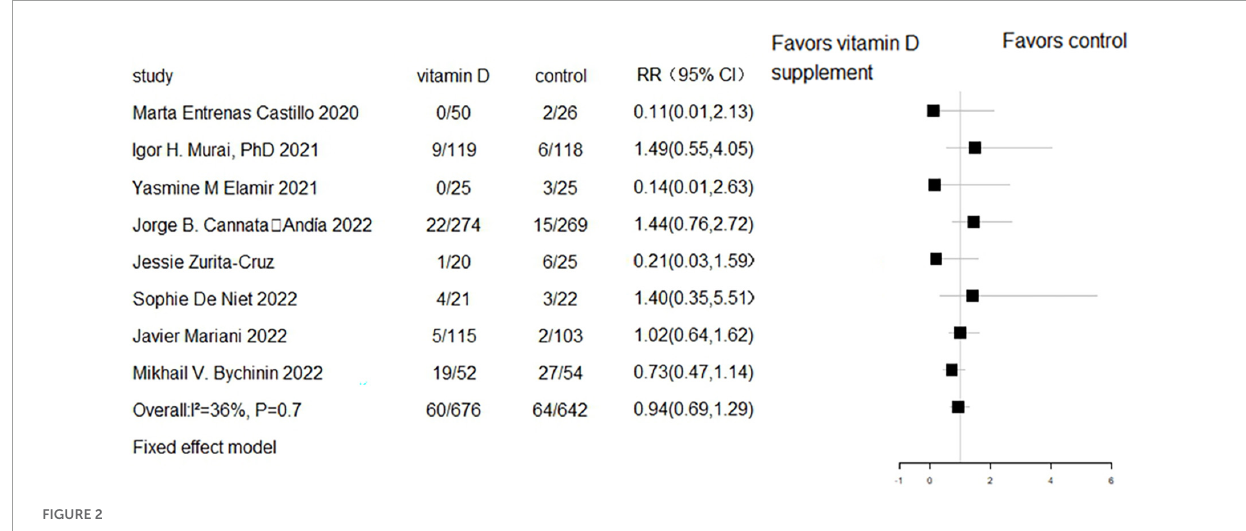
FIGURE2 Forest plot of RCTs for vitamin D supplementation on mortality.